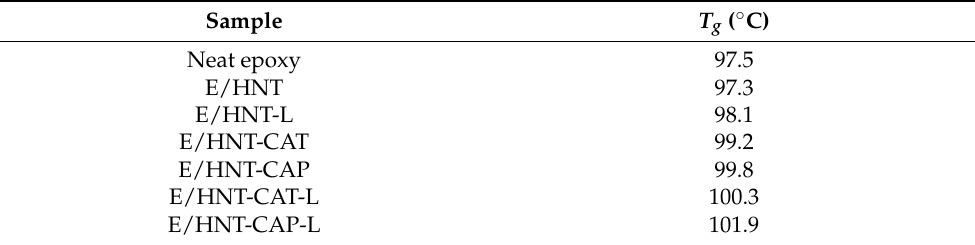
Table 5. The values of T g measured for the neat epoxy and its nanocomposites.